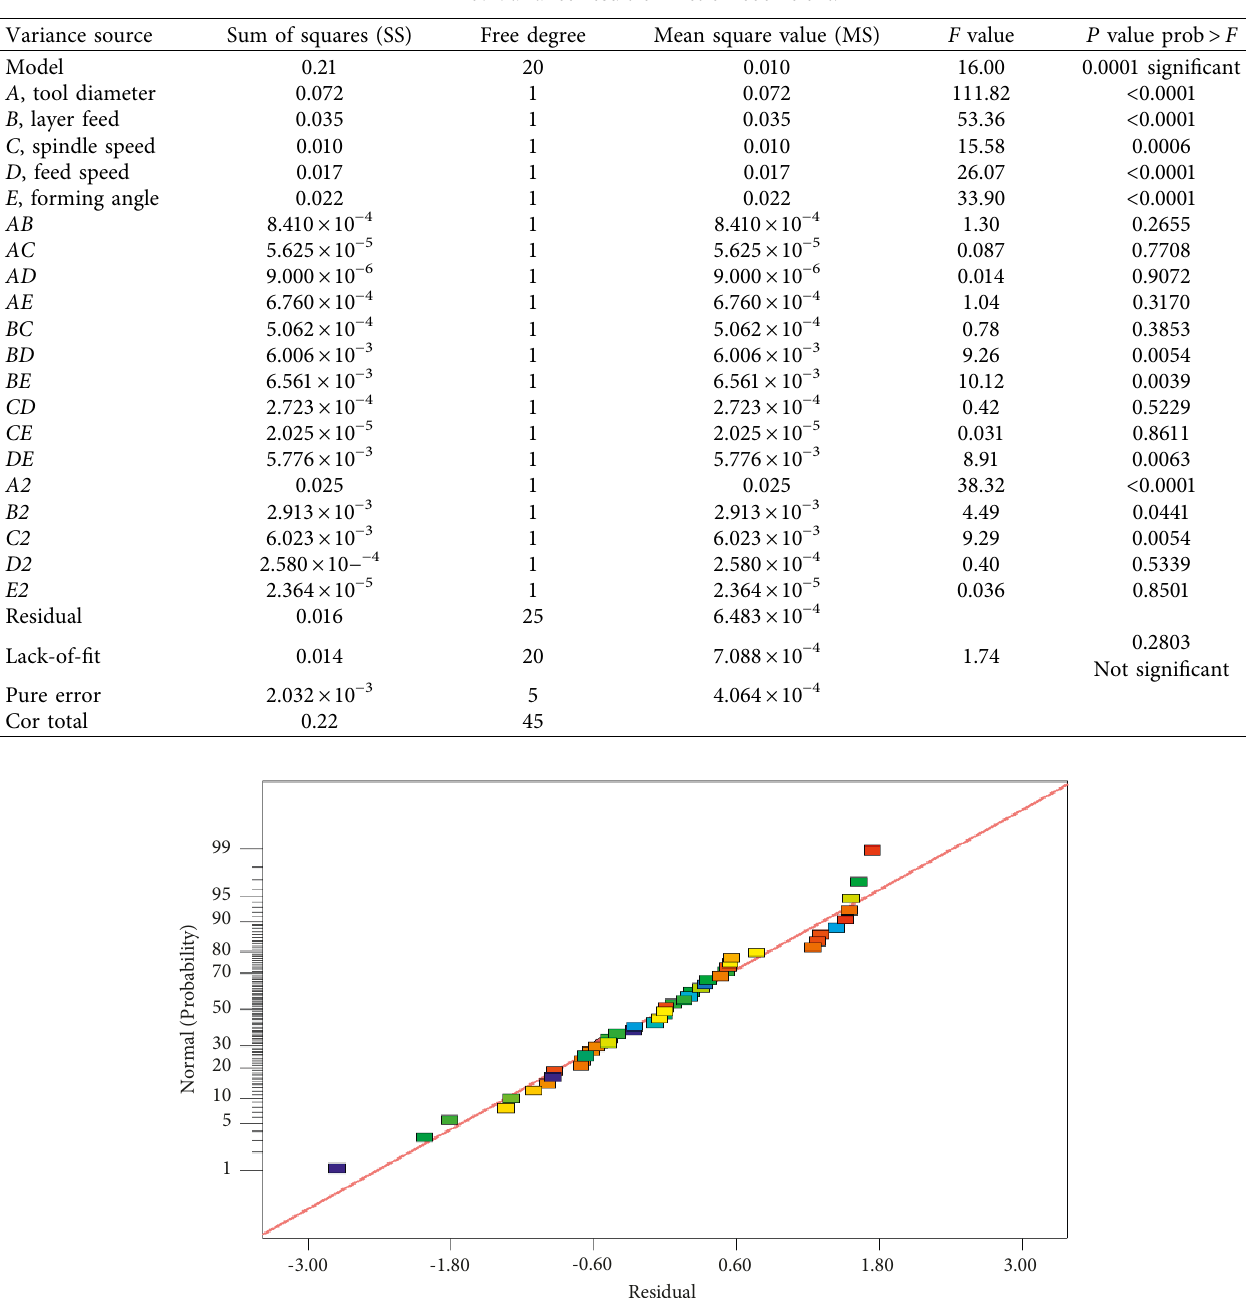
Figure 14: Normal probability graph of friction coefficient residuals.